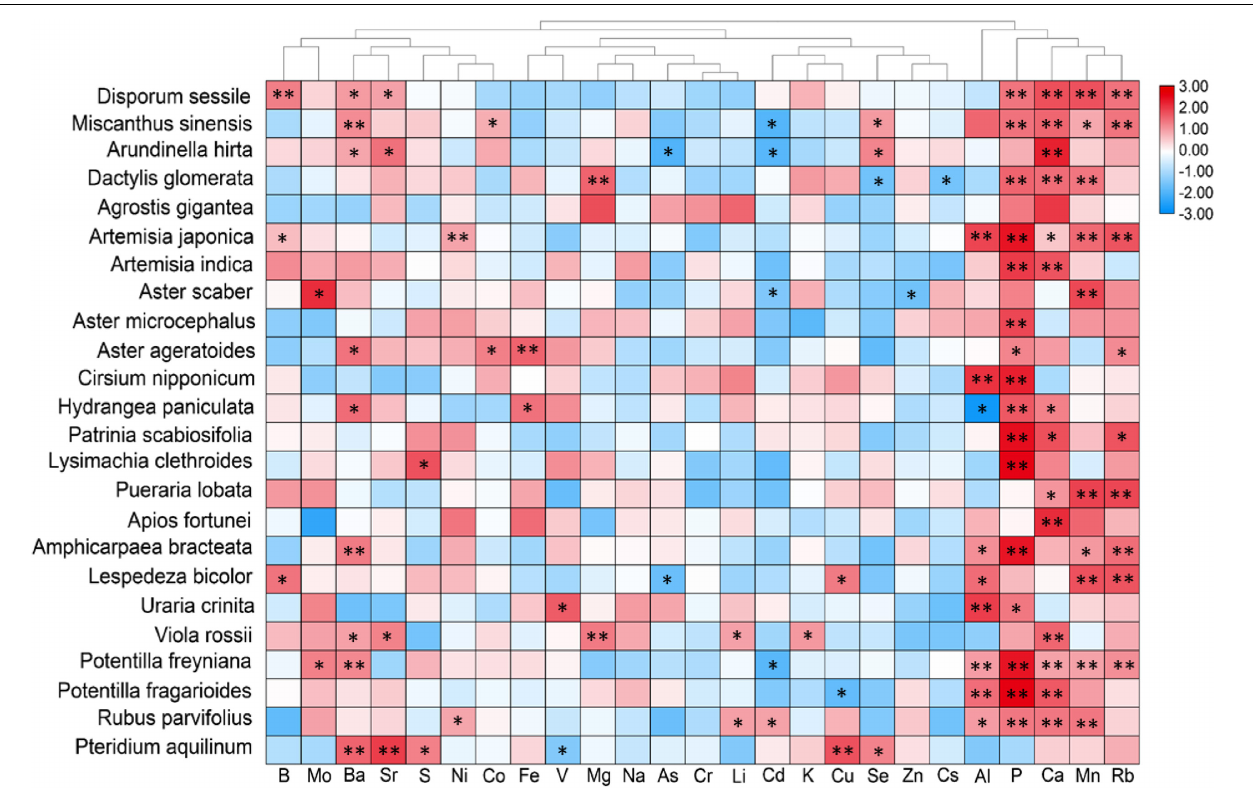
FIGURE 5 | Heatmap showing correlation coefficients between leaves of different plant species and soil elemental concentrations. For soil elemental concentration data, P was shown as Bray II-P, and Soil B and Li were presented as a water-extractable form, respectively, whereas others were presented as a ammonium acetate-extractable form. Hierarchical cluster analysis was applied to minerals but not to plant species. Row data were normalized to fit the size relations of the correlation coefficients ( r ) for better visualization. The r was evaluated through Pearson’s correlation analysis. * and ** represent p < 0.05 and p < 0.01,